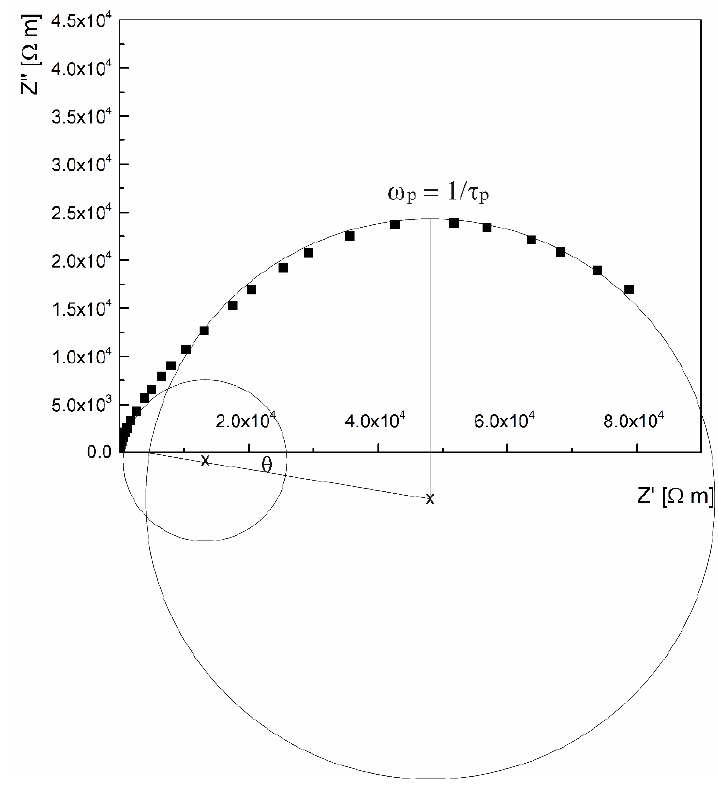
Figure 7. Nuqist plot for BaTiO 3 /NiFe 2 O 4 sintered at 1150 °C. Variations of relative dielectric constant, tangent loss, and AC conductivity with the